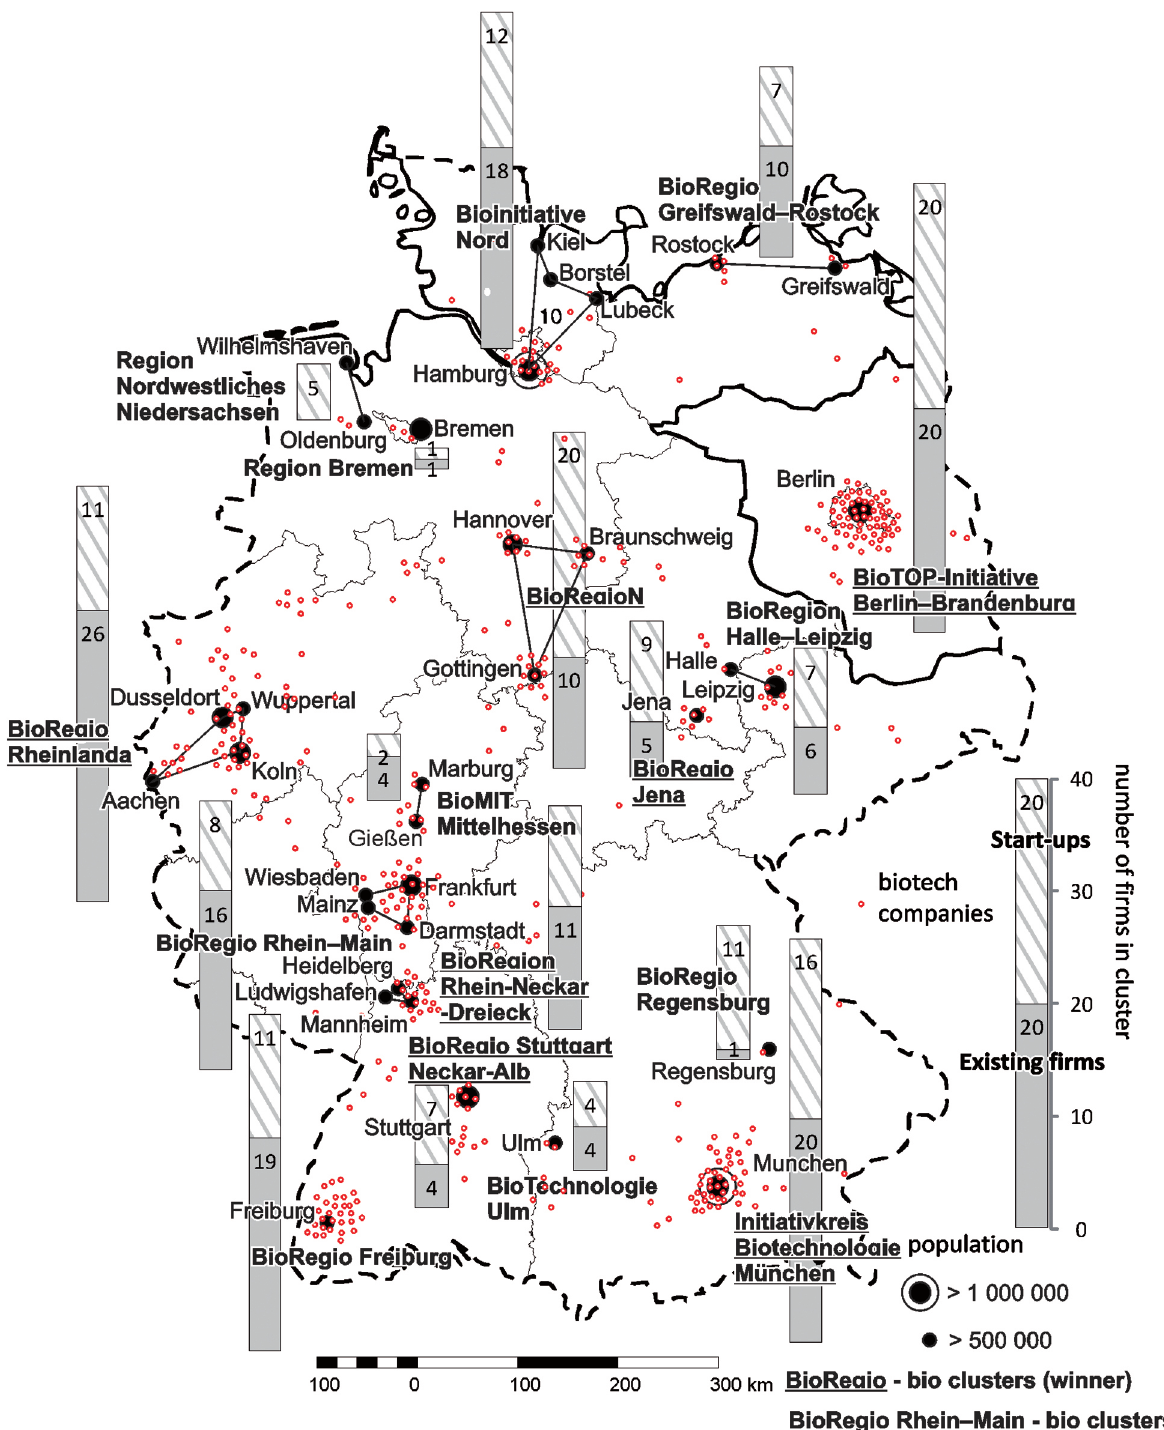
Fig. 5. German biotech clusters in 1996, the distribution of biotech companies (one dot can represent one or more companies) and their change 1996–1998 Source: own studies on the basis of Dohse